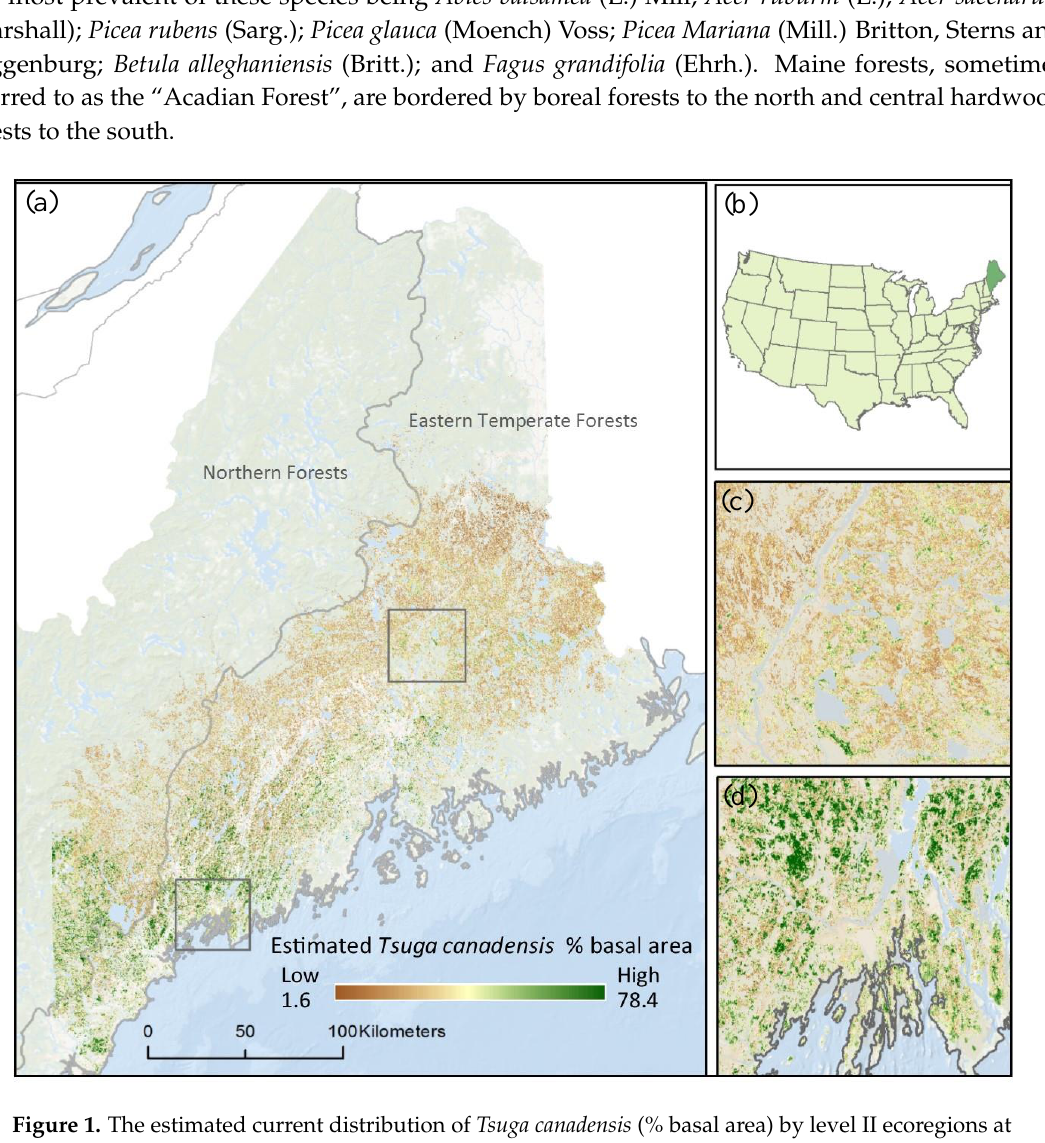
Figure 1. The estimated current distribution of Tsuga canadensis (% basal area) by level II ecoregions at 30 m resolution throughout the state of Maine ( a ). Maine is located in the northeastern corner of the U.S. ( b ); Zoom 1 shows relatively low levels of Tsuga canadensis (% basal area) ( c ); and Zoom 2 shows coastal region with higher levels of Tsuga canadensis (% basal area) ( d ).